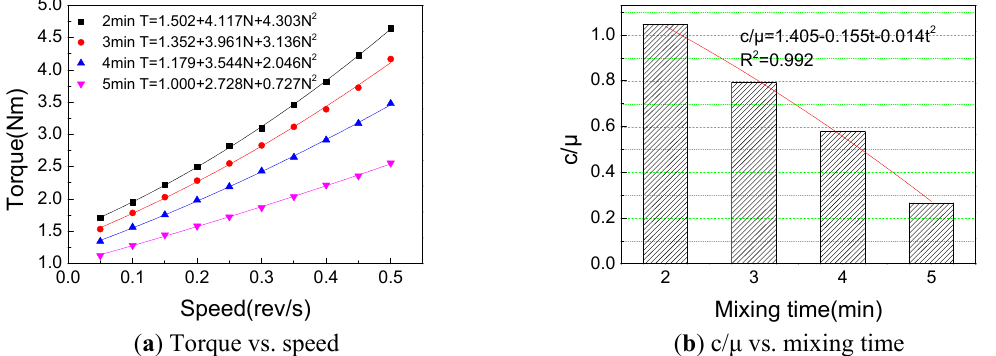
Figure 7. Effect of mixing time on shear thickening behaviour of SCC. Figure 7. E ff ect of mixing time on shear thickening behaviour of